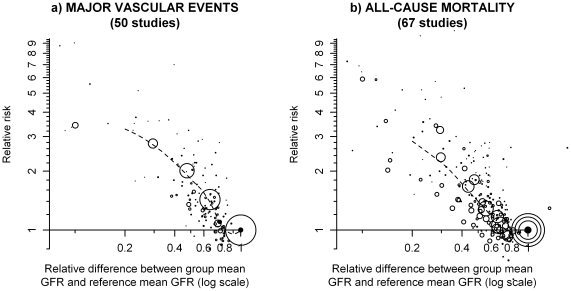
Relationship between eGFR and risk of major vascular events and all-cause mortality.Relative risks are shown on the log scale. The area of each plotting symbol is proportional to the amount of statistical information (i.e. it is inversely proportional to the variance of the floated log odds ratio). The dashed lines represent the best local polynomial regression fits.